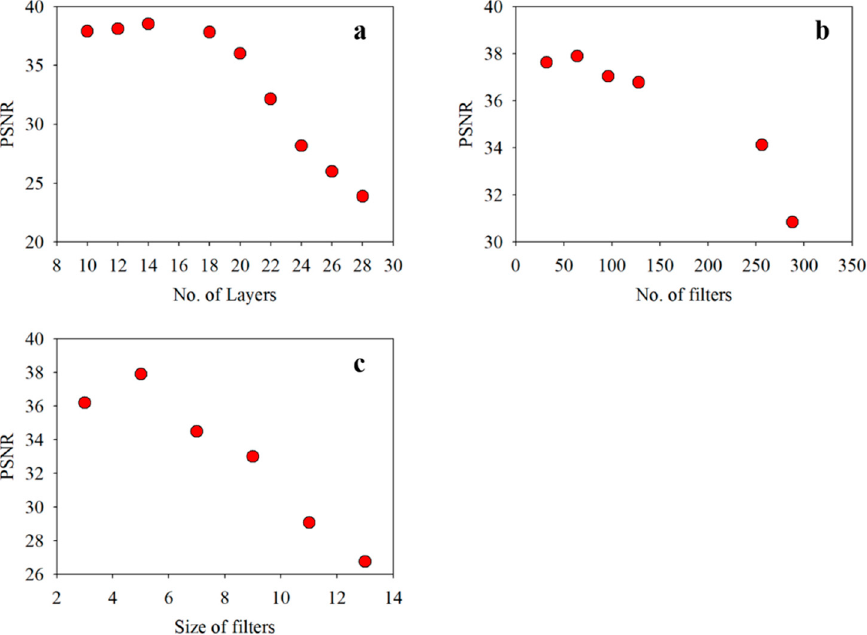
Figure 6. Sensitivity analysis of the variational capsule network (VCapsNet) in terms of ( a ) net- work depth; ( b ) size of filters; and ( c ) number of filters for